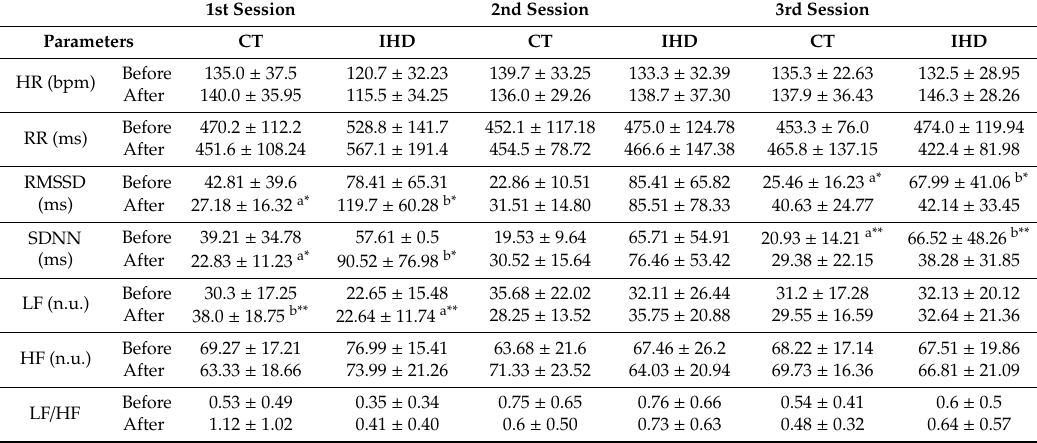
Table 3. Means and standard deviations for the heart rate variability (HRV) indexes (RR interval - RR, standard deviation of the means of normal RR intervals calculated at five-minute intervals – SDNN, square root of the mean squared di ff erences of consecutive RR intervals – RMSSD, low frequency – LF, high frequency – HF, and low frequency / high frequency ratio – LF / HF) of dogs with IRIS CKD Stage 4 undergoing CT and IHD, before and after the treatment